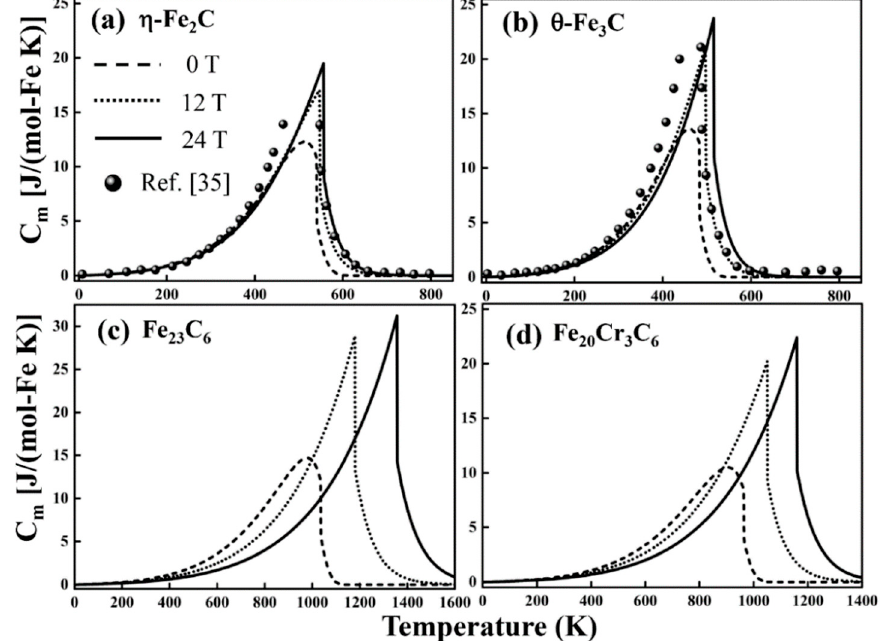
Figure 6. The magnetic-field-induced heat capacity of carbides with (dotted and solid lines) and without (dash lines) magnetic fields. ( a ) η -Fe 2 C and reference data (ball symbols) [35], which were obtained in the absence of a magnetic field; ( b ) θ -Fe 3 C and reference data (ball symbols) [35]; ( c ) Fe 23 C 6 ; ( d ) Fe 20 Cr 3 C 6 .